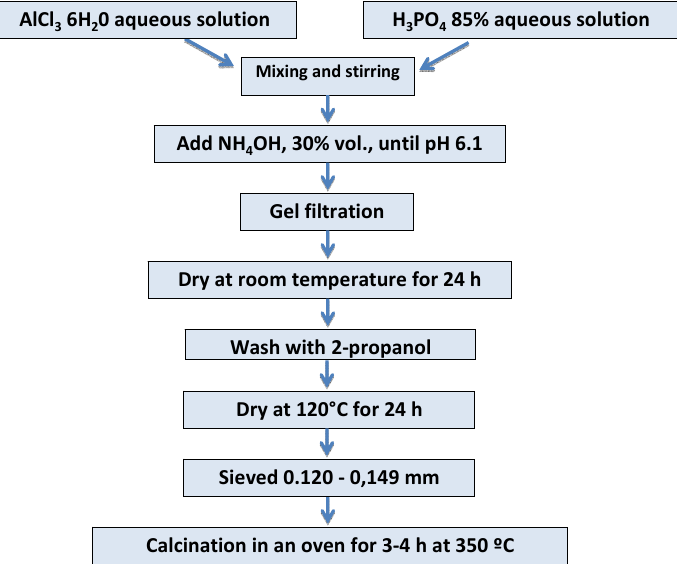
Figure 4. Chart flow of the sol-gel preparation schedule for amorphous aluminium phosphate